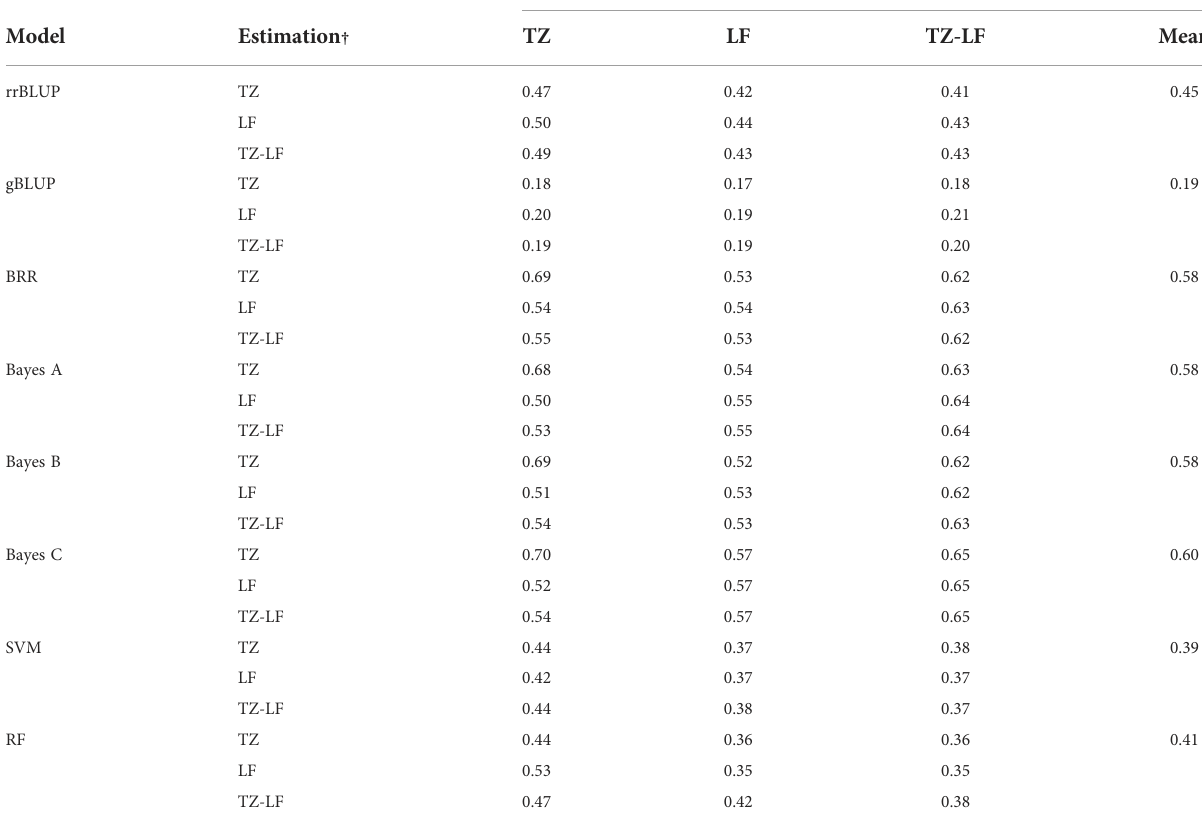
TABLE 4 The genomic prediction accuracy for two years (2014 and 2015) of biomass yield in the P149 population validated within and across locations.